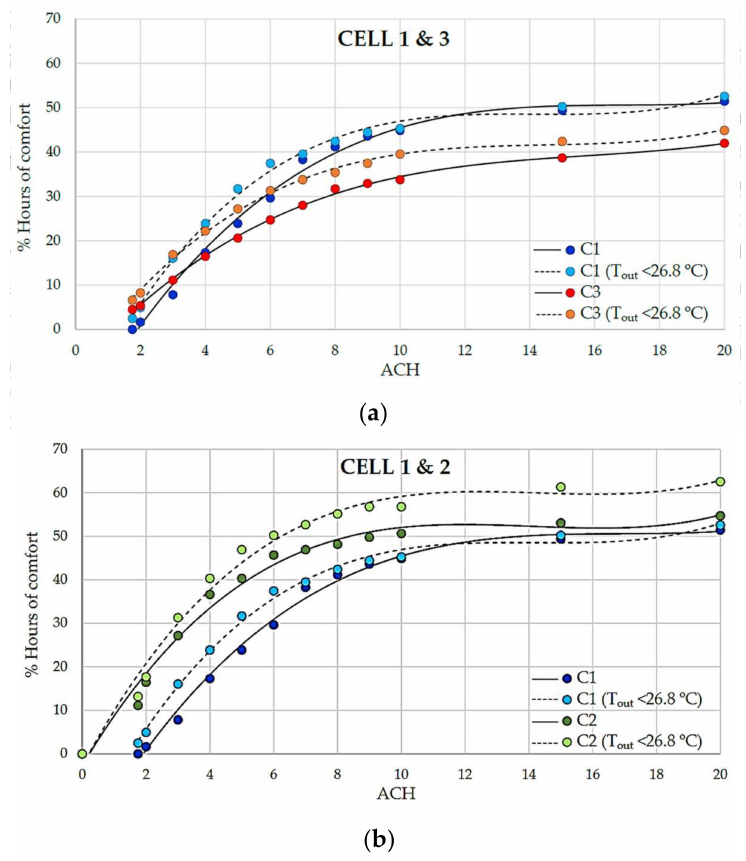
Figure 15. Influence of air changes per hour on the percentage of comfort hours in the September protocol (night-time ventilation): ( a ) retrofitted C1 and non-retrofitted C3; and ( b ) retrofitted south-facing C1 and north-facing